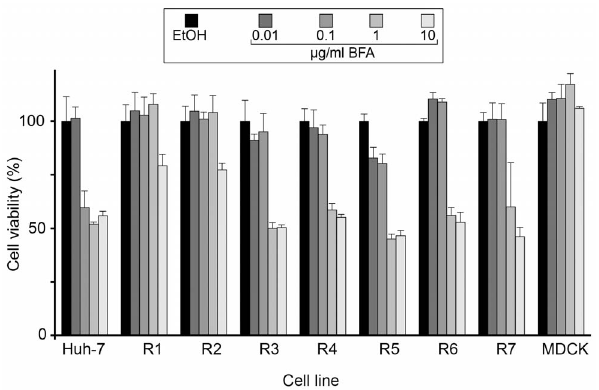
Figure 1. Viability of BFA-resistant cells. Sub-confluent cells of the indicated cell lines were cultured in 96-well plates in the presence of the indicated concentrations of BFA or of 0.2% ethanol (BFA stock solvent) for 24 h. Viability was assessed using an MTS assay. The absorbance of the ethanol-treated sample is expressed as 100%. Results were expressed as percentages of the values obtained with no BFA. Error bars represent the SEM of 2 independent experiments performed in triplicates.